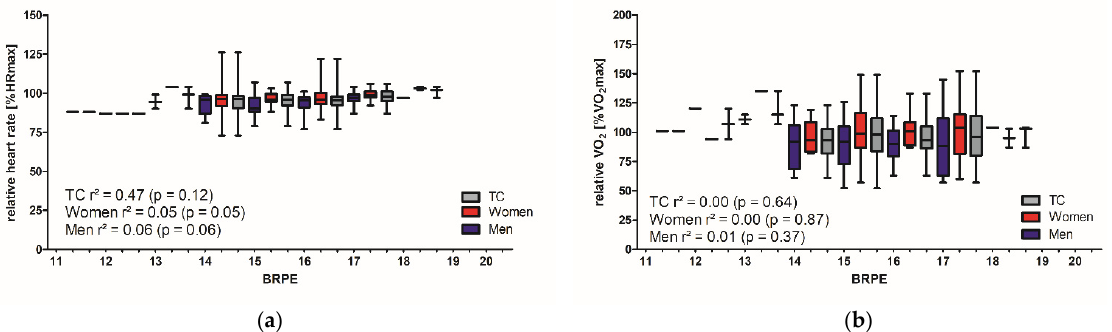
Figure 2. Measurements of exercise intensity and BRPE during the 1 km CTT: differences between genders. ( a ) Relative HR (%HR max ) and ( b ) relative V ̇ O 2 (%VO 2max ) at different maximal BRPE values for the total cohort (TC), women and men.